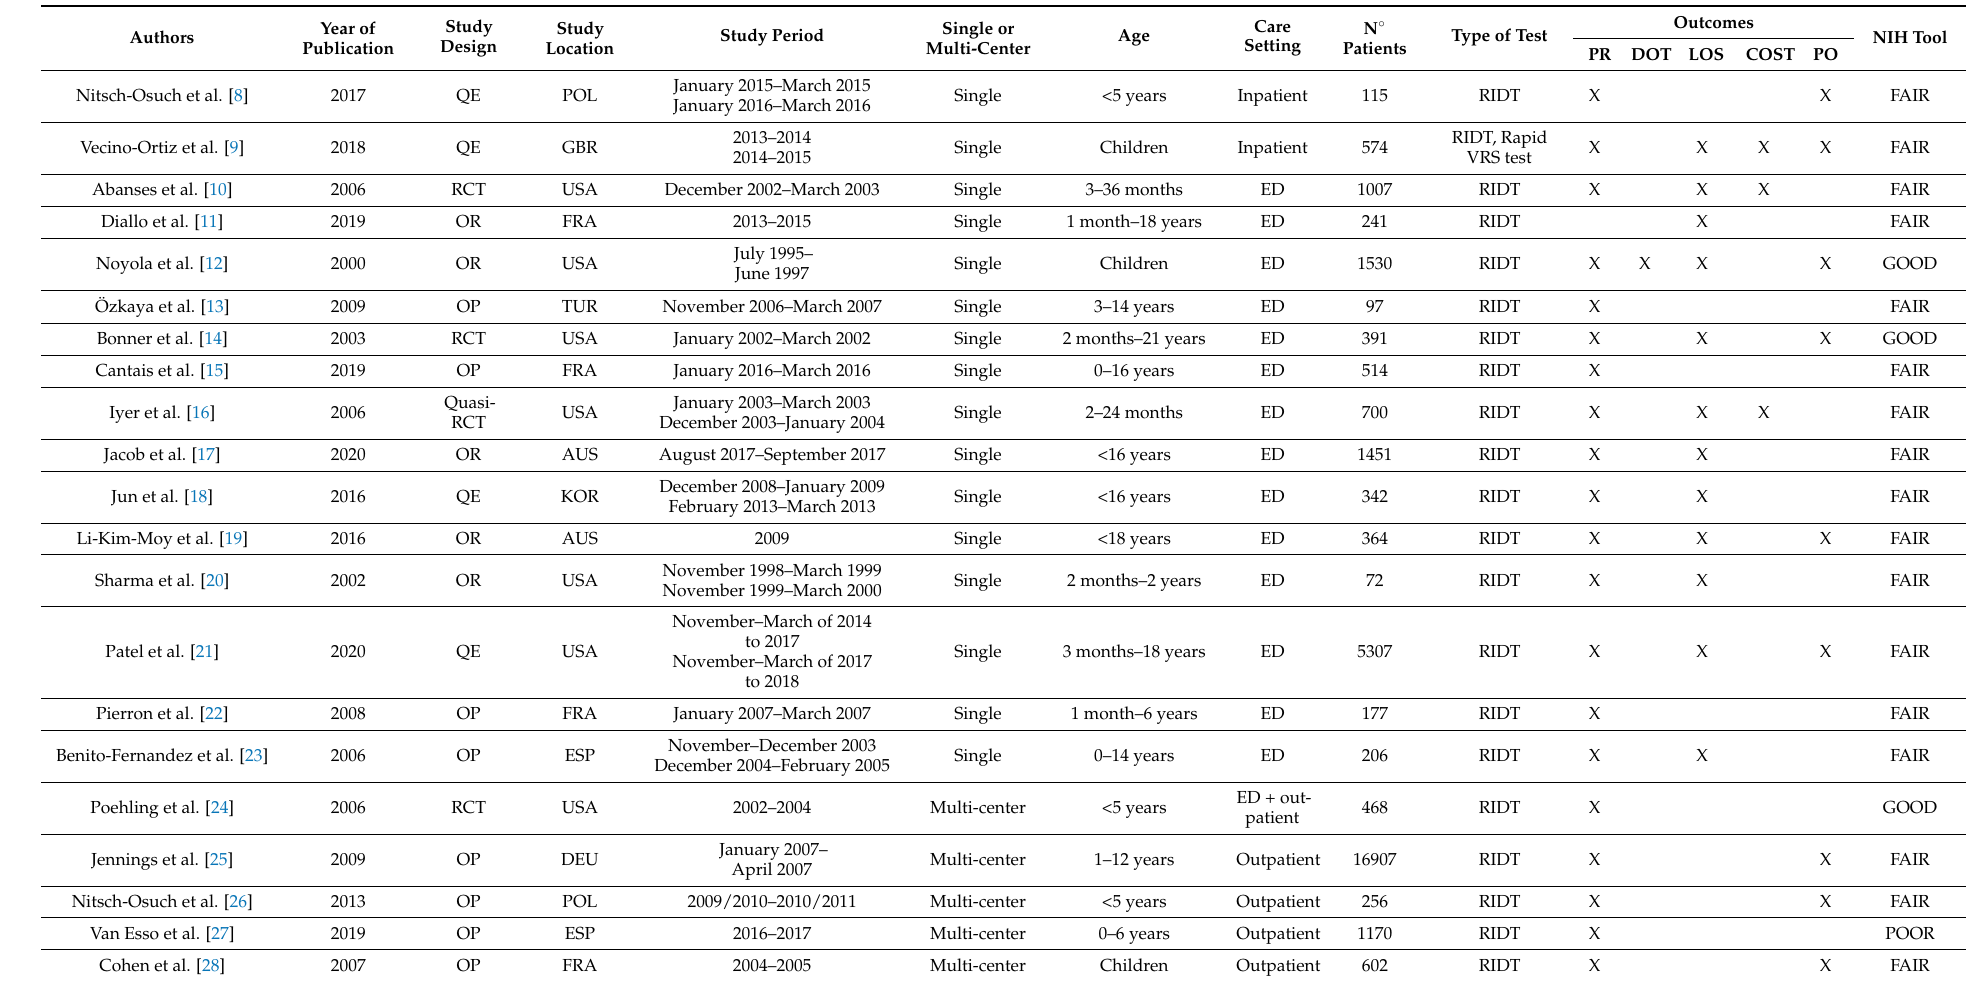
Table 1. Characteristics of studies included in the